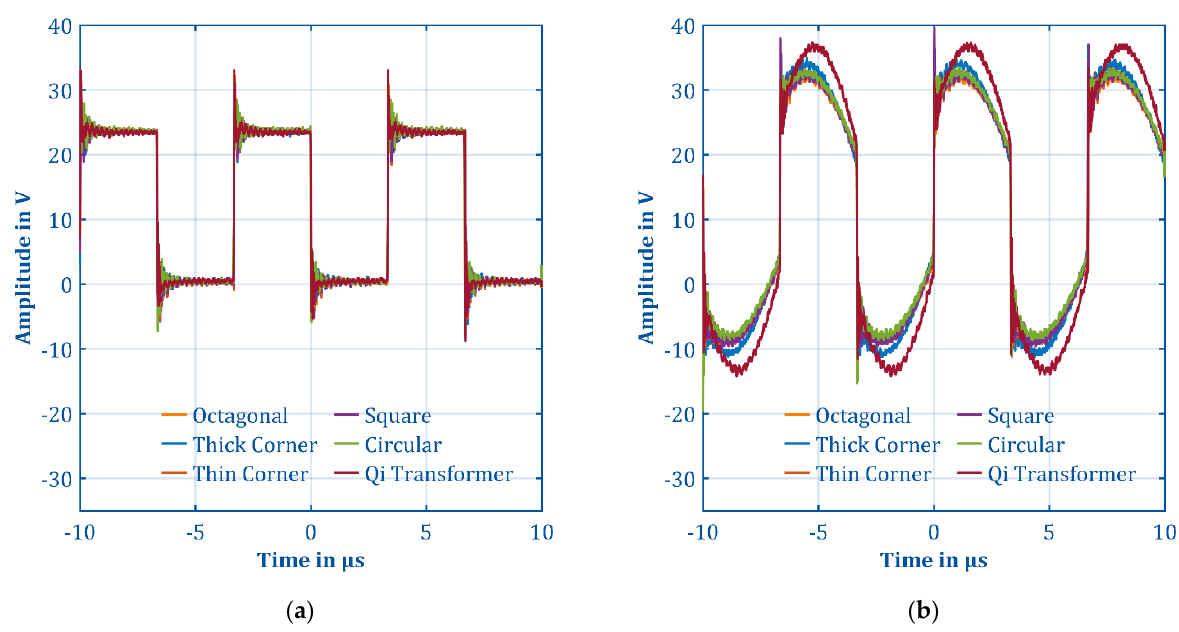
Figure A3. ( a , b ) Show the voltage signals at the primary winding of the transformers at 150 kHz. Figure A4a,b show the voltage signals at secondary winding of the transformer at 150 kHz. Figure A3a shows the secondary winding connected directly to the voltage rectification and regulation electronics and Figure A4b shows the primary winding connected through the coupling capacitor to the voltage rectification and regulation electronics in Figure 4.